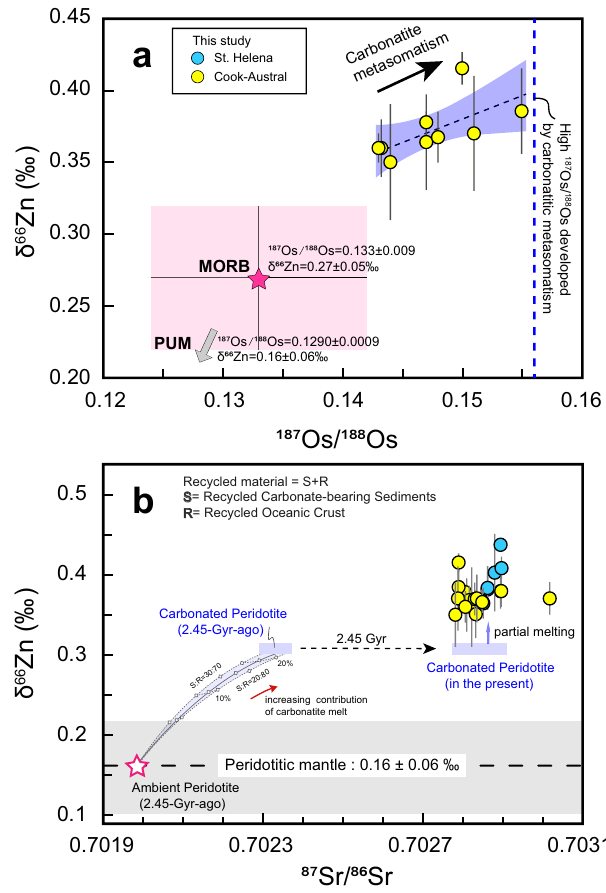
Fig. 3 | Variations in δ 66 Zn versus age-corrected 187 Os/ 188 Os values (a) and 87 Sr/ 86 Sr values (b) of HIMU basalts. In Figure 3a, Age-corrected 187 Os/ 188 Os values for Cook-Austral samples are from ref. 35 (Supplementary Table 7). The blue line represents the calculated high 187 Os/ 188 Os ratio (0.156, ref. 16) for carbonatite- metasomatized peridotite mantle 16 . Error bars on δ 66 Zn represent 2 standard deviations (2SD) uncertainties. In Figure 3b, δ 66 Zn value of peridotitic mantle is given by ref. 27. The black dashed line marks the average value and the gray fi eld highlightsthe uncertaintyrange.Alldatasource forfactorsofcalculationsin a and b are given in Supplementary Information, Note 6. MORB=Mid-Ocean Ridge Basalt. PUM=Primitive Upper